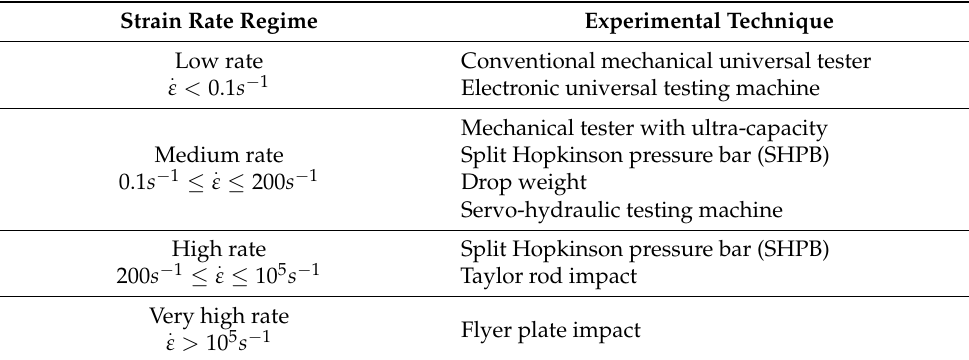
Table 1. Summary of strain rate corresponding experimental